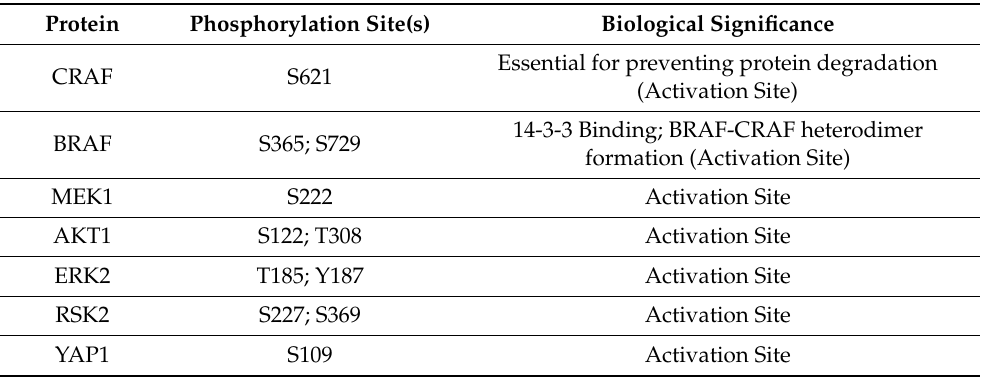
Table 1. Table of phosphorylated proteins identified by mass spectrometry in the EVs isolated from CTCs with active site identified and biological significance of the site in protein signaling pathways.